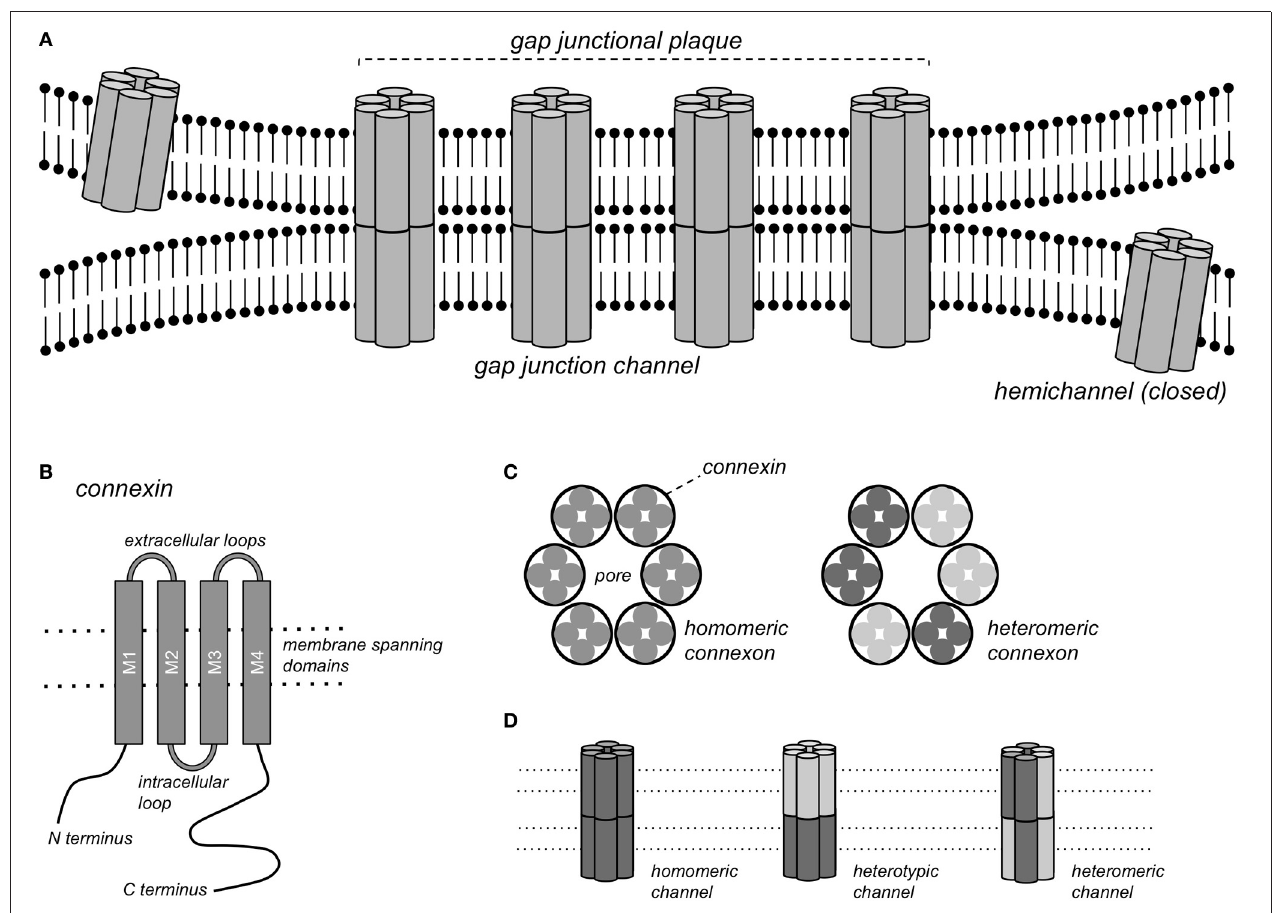
FIGURE 1 | Gap junction channels. (A) Schematic representation of a gap junctional plaque, with each of the neighboring cells contributing one hemichannel to form the complete gap junction channel. (B) Structure of the pattern of a single connexin subunit with 4 domains traversing the membrane. (C) A hemichannel or connexon consists of a hexagonal